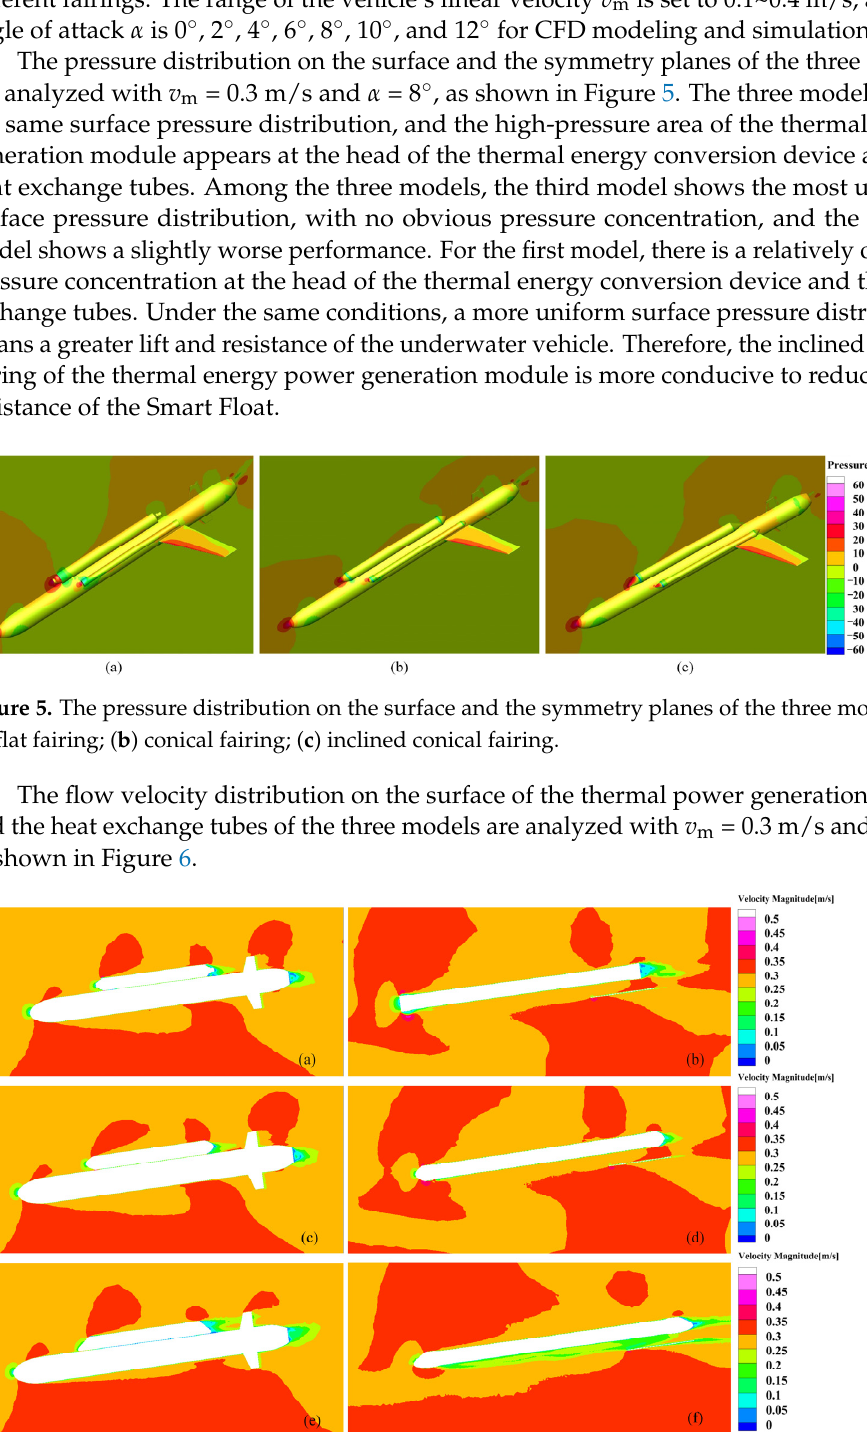
Figure 6. The cross-sectional flow velocity distribution of the thermal energy conversion device